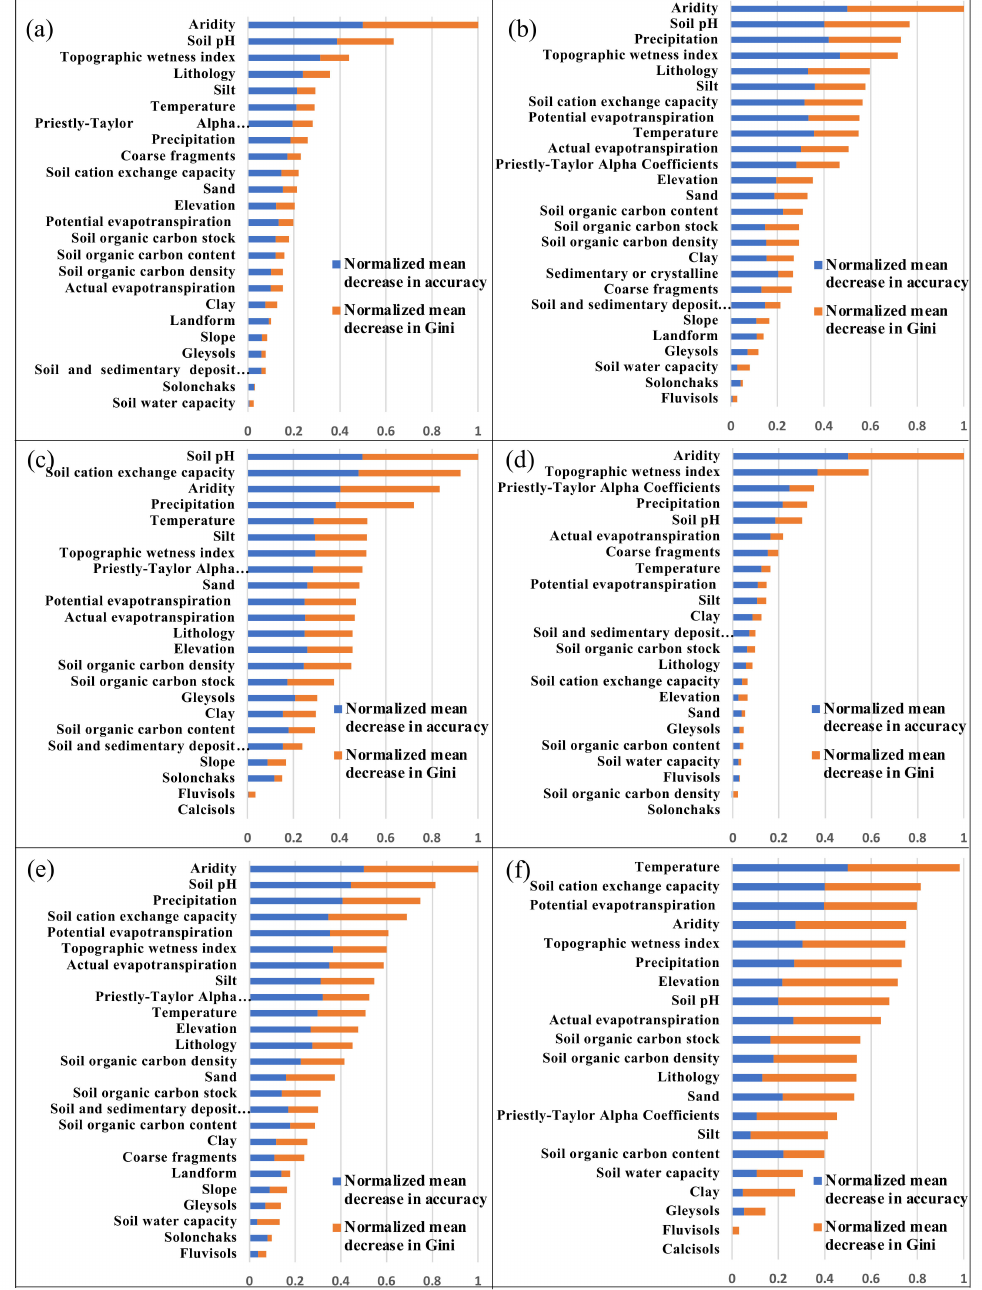
Figure 5. Normalized importance of predictors in terms of mean decrease values in accuracy and in Gini node impurity in the ( a ) pure overall model (1A-ML-Pure); ( b ) pure overall model with sedimentary or crystalline as the predictor (1B-ML- Pure with Geol); ( c ) hybrid shallow model (2A-HML-Shal); ( d ) hybrid deep model (2B-HML-Deep); ( e ) hybrid sedimentary model (3A-HML-Sed); and ( f ) hybrid crystalline model (3B-HML-Cry). Decreases in both the mean values in accuracy and in Gini node impurity were normalized by their largest value,